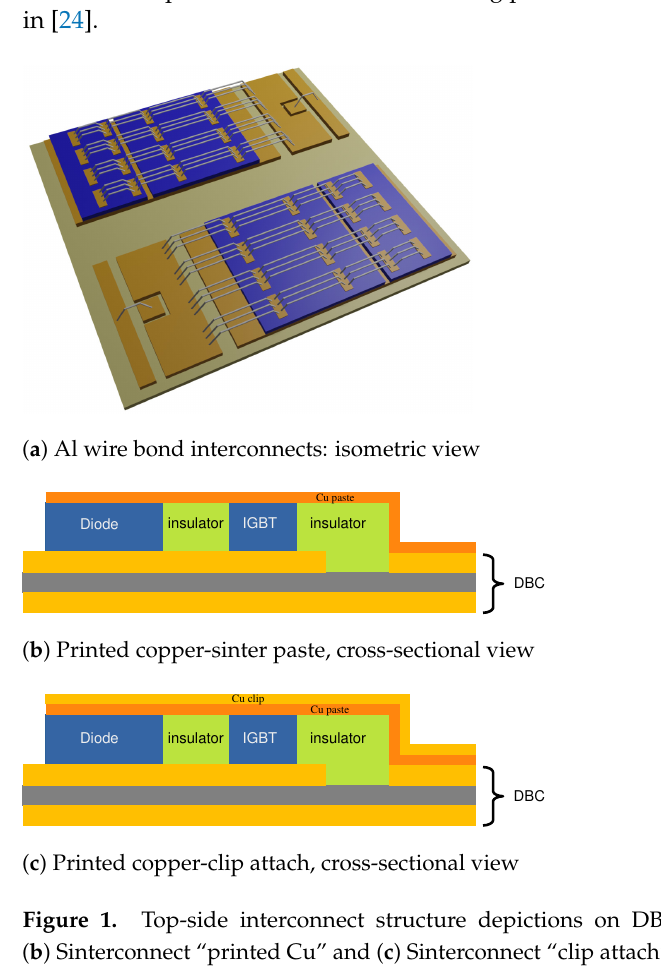
Figure 1. Top-side interconnect structure depictions on DBC subassemblies; ( a ) wire bond, ( b ) Sinterconnect “printed Cu” and ( c ) Sinterconnect “clip